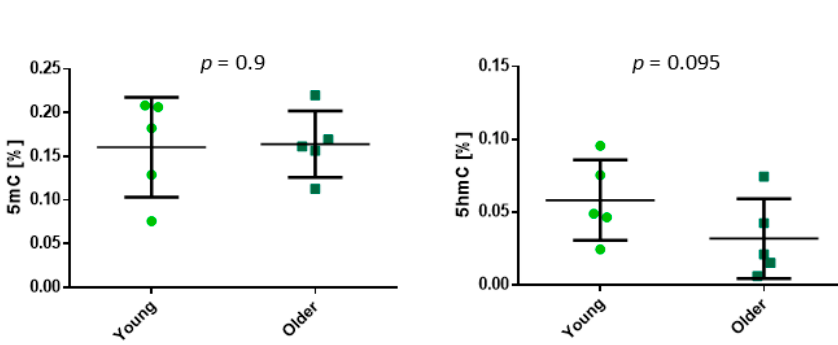
Figure 2. Levels of 5-methylcytosine (5mC), 5-hydroxymethylcytosine (5hmC), 5-formylcytosine (5fC) and 5-carboxylcytosine (5caC) in human dermal fibroblasts. ( A ) Levels of DNA methylation and methylation derivatives in dermal fibroblasts evaluated with the dot-blot method. ( B ) Levels of DNA methylation and hydroxymethylation in dermal fibroblasts evaluated with the colorimetric method. The statistical analysis was performed with the Mann–Whitney U -test. Young: 22–35 years old. Older: 74–94 years old.